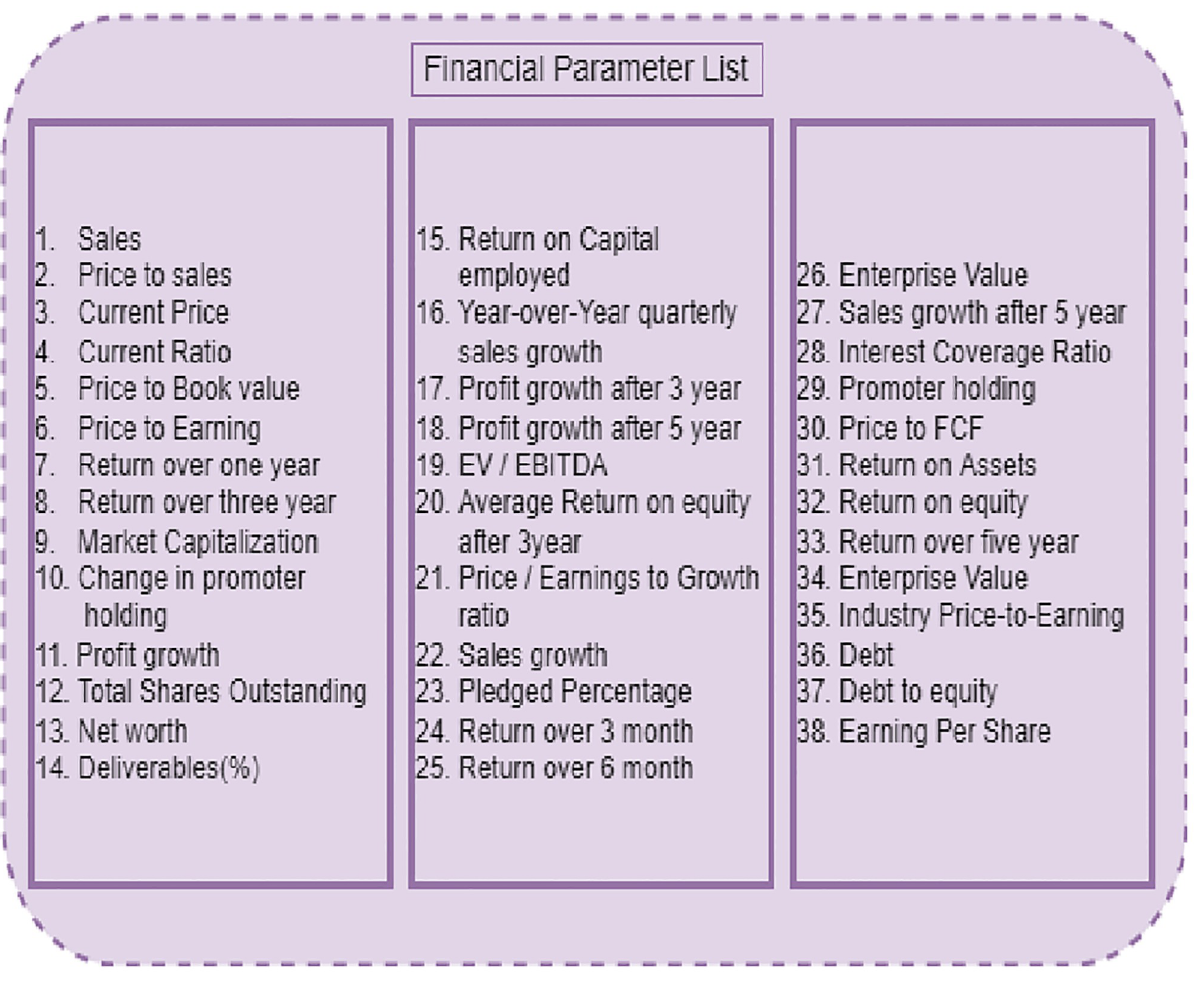
Fig 4. UFS based final selected